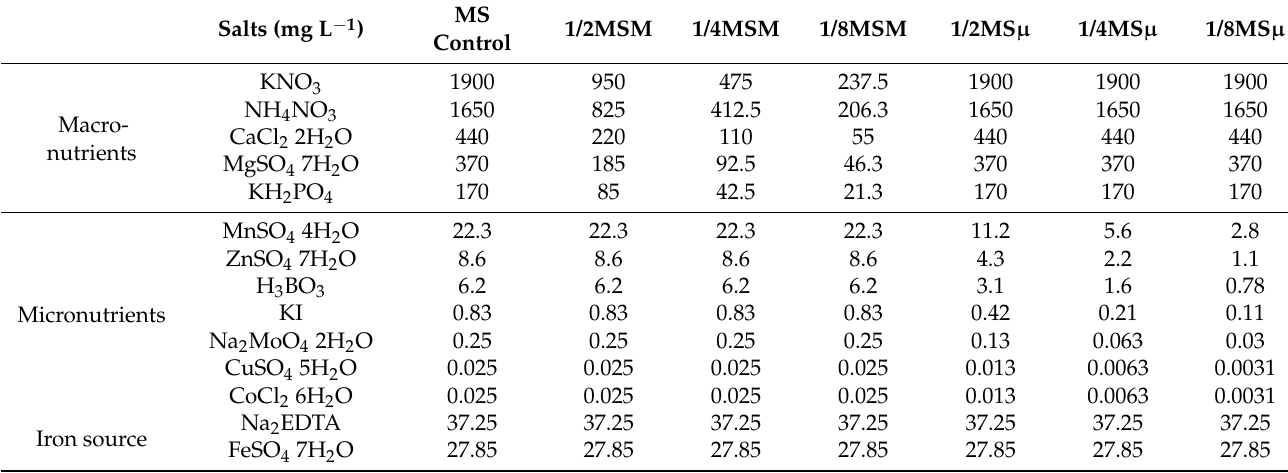
Table 3. The salt composition (mg L − 1 ) of the seven culture media formulations used in this study based on the Murashige and Skoog medium